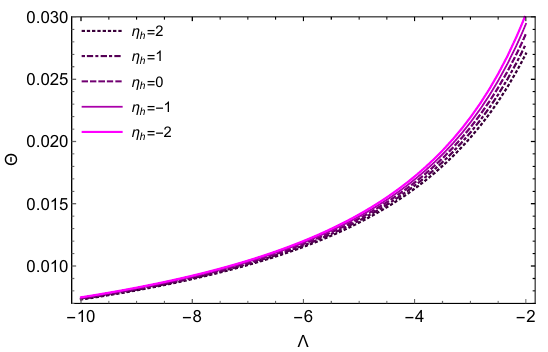
Figure 4 . Signi(cid:12)cantly di(cid:11)erent choices of (cid:17) h , parameterizing e(cid:11)ects beyond our truncation, only lead to slight quantitative changes of the critical exponent (cid:2) in the regime (cid:3) < (cid:0) 1 that we focus on in section